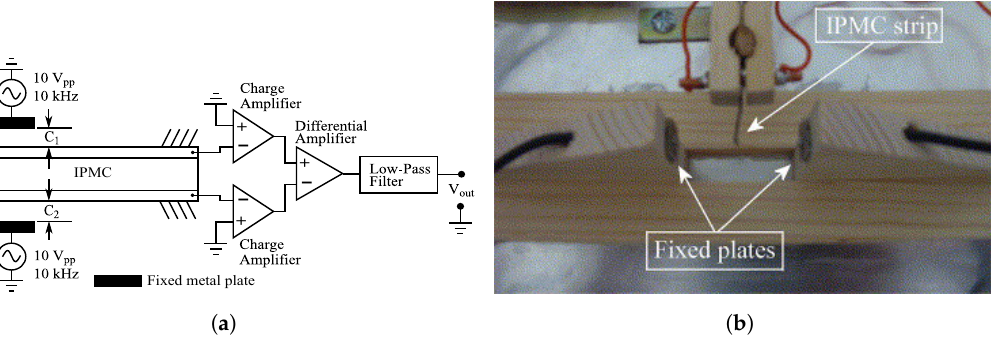
Figure 12. IPMC sensing method that relies on measuring capacitances between IPMC electrodes and fixed metal plates. ( a ) Schematic. ( b ) Experimental set-up (reproduced from [142], Copyright (2005), with permission from